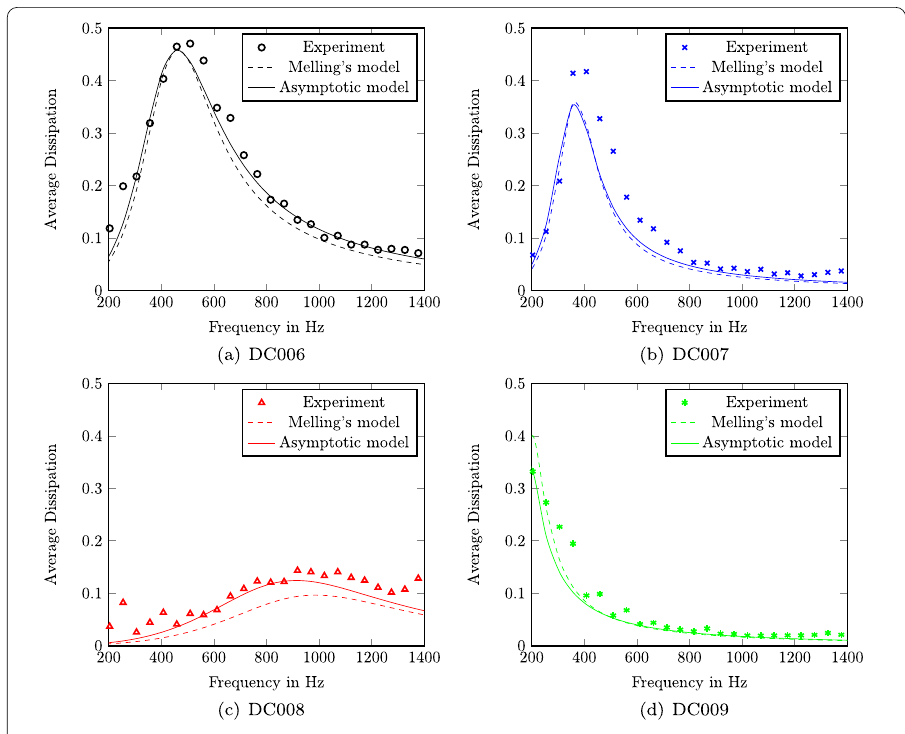
Figure 10 Average dissipation from experiments and numerical modelling plotted over the frequency comparing models for DC006, DC007, DC008,